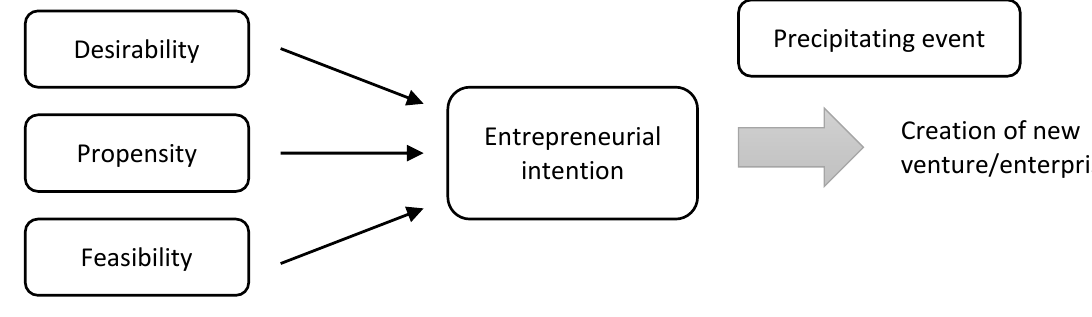
Figure 1. Entrepreneurial Event